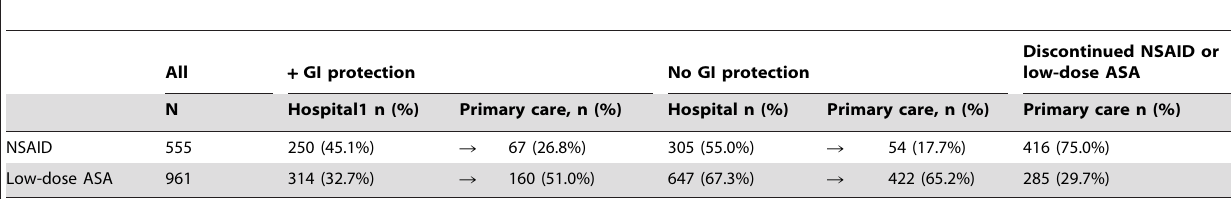
Table 3. Numbers and prevalence rates of concurrent use of GI protection for users of NSAID and low-dose ASA treatment initiated by hospital physicians during hospital stay.